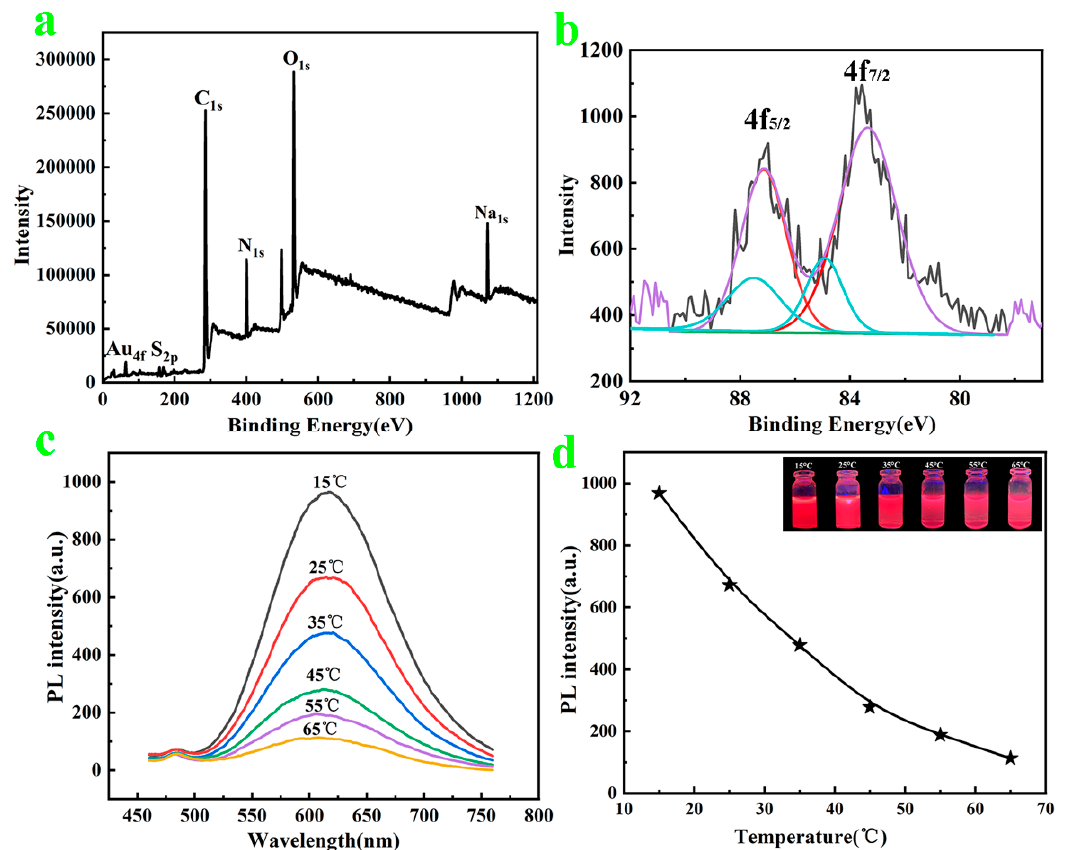
Figure 2. ( a , b ) XPS energy spectrum of AuNCs and Au4f of AuNCs; ( c ) AuNC fluorescence spectra at different temperatures; ( d ) different temperature peak-fluorescence intensities of AuNCs (inset is color change of AuNCs under UV lamp at different temperatures).